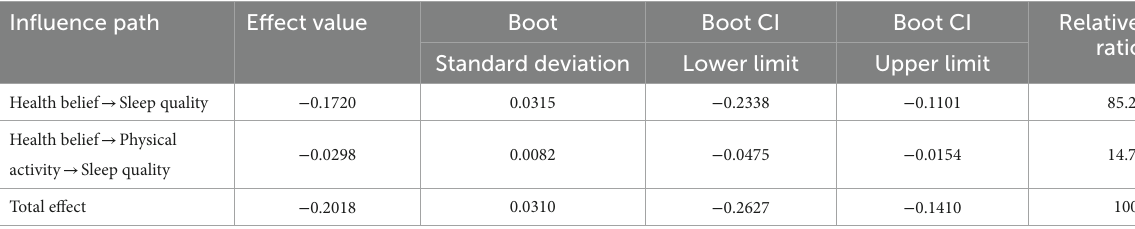
TABLE 4 Bootstrap analysis of the significance test results of mediating effect.